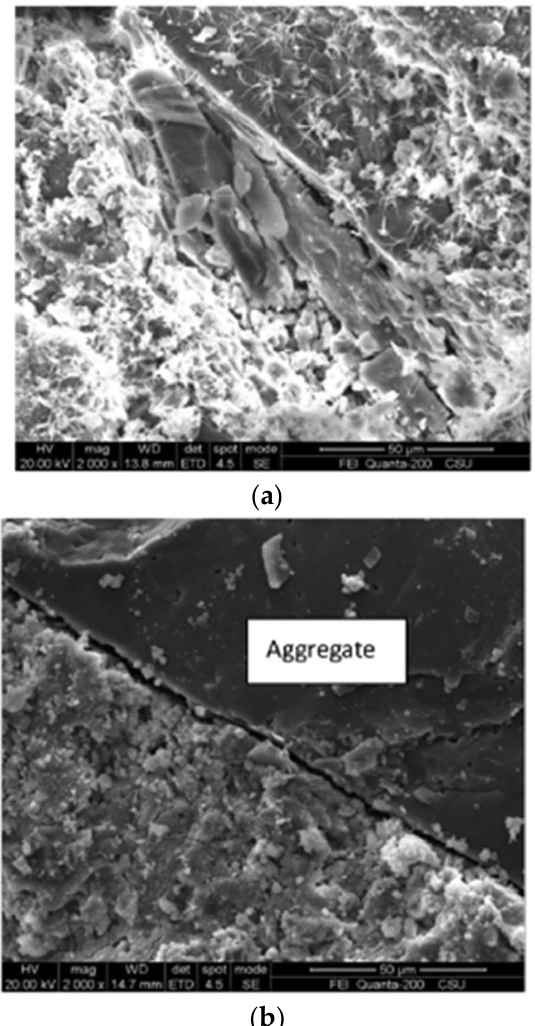
Figure 4. SEM images of ( a ) old ITZ in RCA; ( b ) carbonated RCA [36]. Reproduced with permission from [36], Elsevier, 2018.